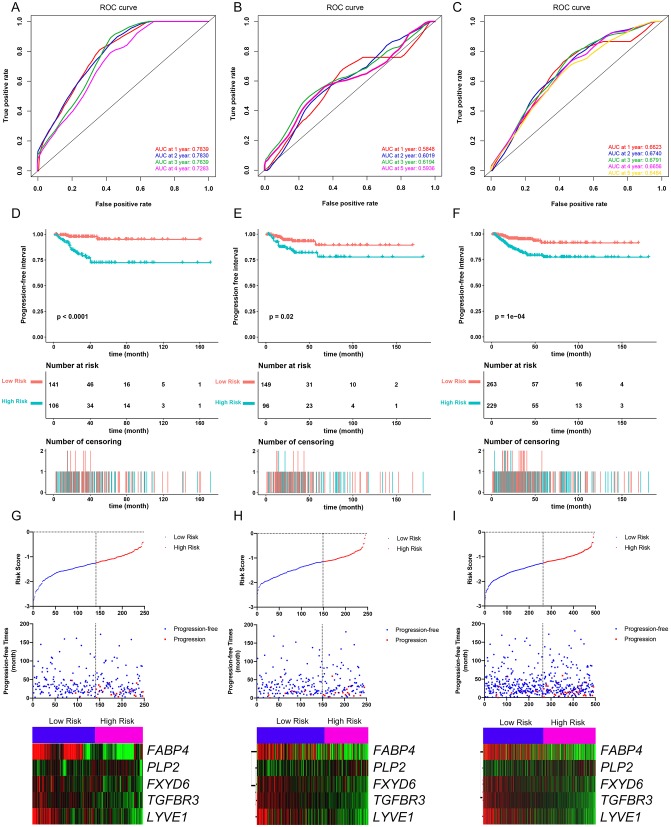
Evaluation of the performance of the five-gene prognostic model in the training dataset and confirmation based on the validation dataset and the entire TCGA-THCA dataset. (A) The time-dependent receiver operating characteristic (ROC) for 1-, 2-, 3-, and 4-year progression-free interval (PFI) predictions for the five-gene signature in the training dataset. (B) The time-dependent ROC for 1-, 2-, 3-, and 5-year PFl predictions for the five-gene signature in the validation dataset. (C) The time-dependent ROC for 1-, 2-, 3-, and 4-year PFI predictions for the five-gene signature in the entire TCGA-THCA dataset. (D) The Kaplan–Meier survival curves of the five-gene signature. Patients from the training dataset were stratified into two groups according to the optimal cutoff values for the risk scores calculated by X-Tile software. (E) The Kaplan-Meier survival curves of the five-gene signature. Patients from the validation dataset were stratified into two groups according to the optimal cutoff values for the risk scores calculated by X-Tile software. (F) The Kaplan–Meier survival curves of the five-gene signature. Patients from the entire TCGA-THCA dataset were stratified into two groups according to the optimal cutoff values for the risk scores calculated by X-Tile software. (G) Relationship among the risk score (upper), survival status of patients in different groups (middle), and the expression profiles of the five prognostic genes (bottom) in the training dataset. (H) Relationship among the risk score (upper), survival status of patients in different groups (middle), and the expression profiles of the five prognostic genes (bottom) in the validation dataset. (I) Relationship among the risk score (upper), survival status of patients in different groups (middle), and the expression profiles of the five prognostic genes (bottom) in the entire TCGA-THCA dataset.